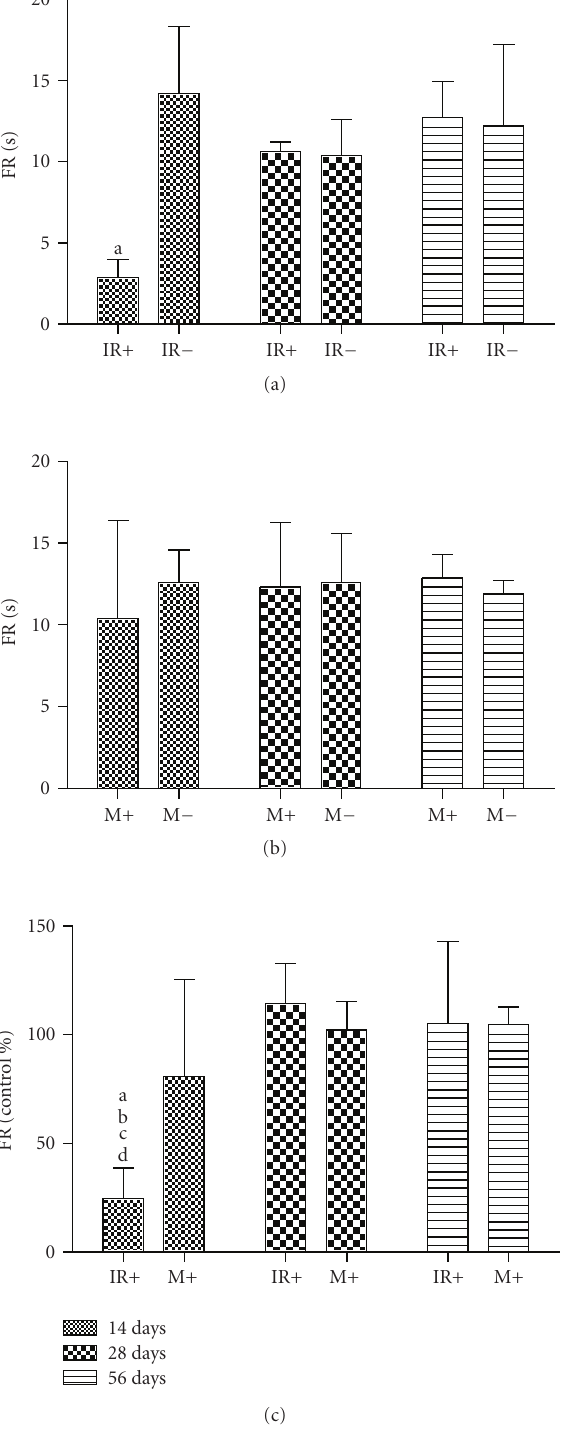
Figure 4: Fatigue resistance of muscles after ischemia-reperfusion injury and myotoxin injury. Values are means ± SEM. Number of data per group is 4–6. IR+: ischaemic/reperfused muscles, IR − : control muscles of ischaemic/reperfused muscles, M+: myotoxin- treated muscles, M − : control muscles of myotoxin-treated muscles. (a) significantly di ff erent from control ( P < . 05), (b) significantly di ff erent from 28 days ( P < . 05), (c) significantly di ff erent from 56 days ( P < . 05), (d) significantly di ff erent from M+.